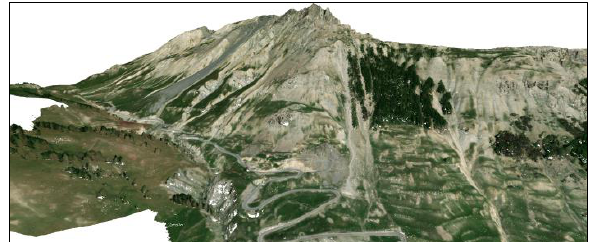
Figure 4. High-resolution 3D model of raw point clouds in RGB